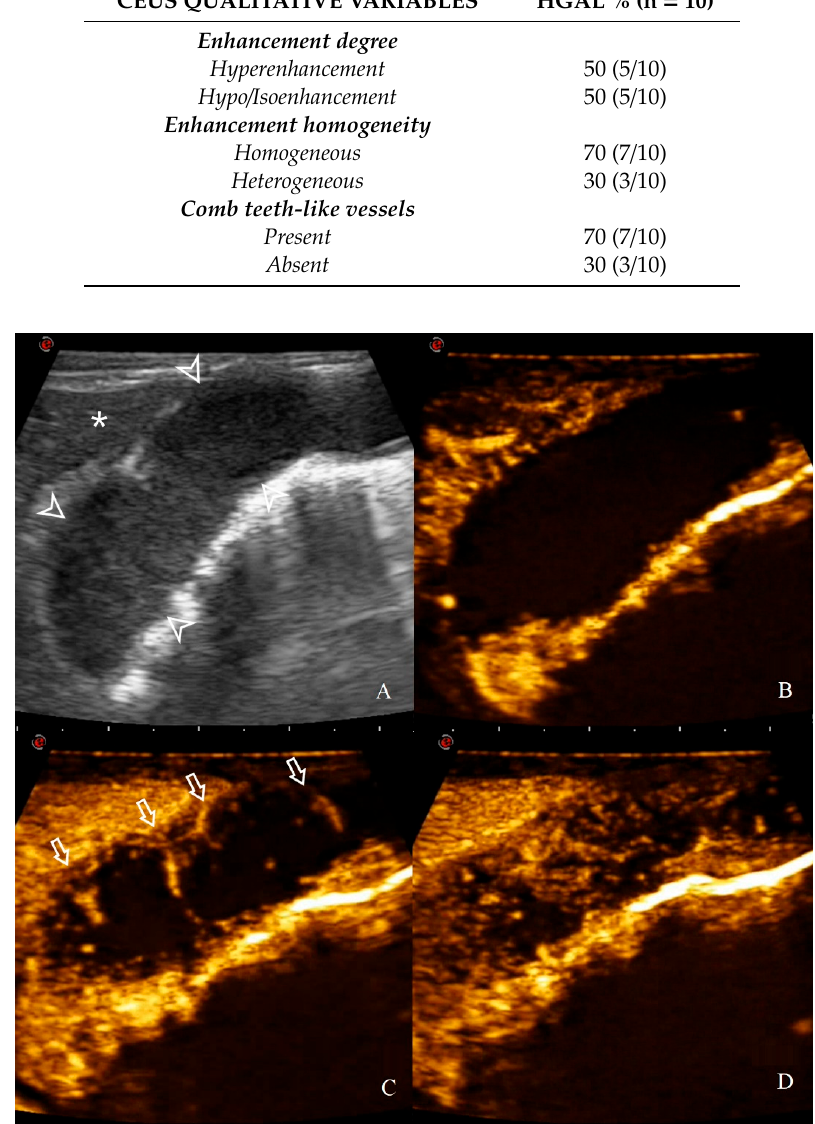
Table 5. Parameters calculated from Receiver Operator Characteristic (ROC) curves of B-mode and CEUS quantitative values for discrimination between low-grade alimentary lymphoma (LGAL) and inflammation (INF).